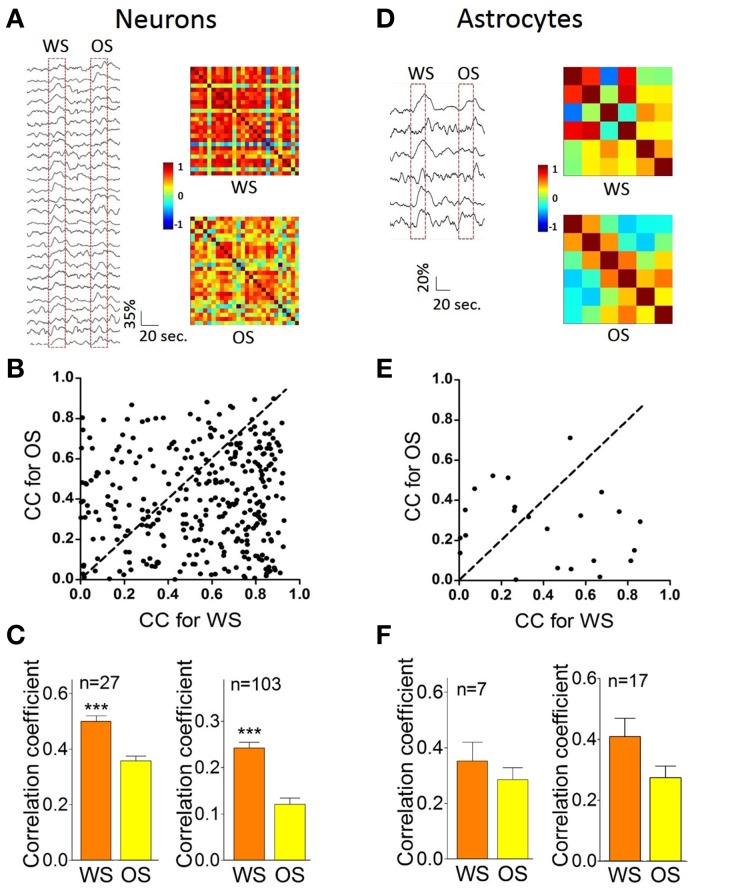
The individual CR cells in the barrel cortex recognize odor and whisker input signals by coding their distinct activity patterns. (A–C) Present the data from neuron pairs and (D–F) show the data from astrocyte-pairs. (A) Shows temporal patterns from CR neurons in response to WS (right-top panel) and OS (right-bottom one) from an experiment, in which the responses of 27 neurons to WS and OS (red dash-line boxes) are presented in left panel. Calibration bars are 35% changes and 20 s. Each pixel in matrices denotes the peak value of correlation coefficient for a pair of cells. Dark-red pixels show the best cross-correlation (synchrony), or vice versa. (B) Illustrates correlation coefficients (CC) for OS vs. CC for WS in this example. A dash-line in 45° denotes equal values in CC for OS vs. CC for WS. The different activity synchronies are seen among most neuron pairs in response to WS and OS. (C) Shows statistical comparisons in CC peak values for the neurons in response to WS and OS from this experiment (left panel; p < 0.001, n = 27; paired t-test), and those for the neurons in response to WS and OS from five experiments (right; p < 0.001, n = 103; paired t-test). (D) Shows temporal patterns from CR astrocytes in response to WS (right-top panel) and OS (right-bottom) from an experiment, in which the responses of the astrocytes to WS and OS are showed in left panel. Calibration bars are 20% changes and 20 s. (E) Shows CC for OS vs. CC for WS in this example. Dash-line in 45° indicates equal values in CC for OS vs. CC for WS, indicating the different activity synchrony among most astrocyte pairs in response to WS and OS. (F) Illustrates statistical comparisons in CC peak values for the astrocytes in response to WS and OS from this experiment (left panel; p = 0.35, n = 7; paired t-test), and those for the astrocytes in response to WS and OS from five experiments (right; p = 0.1, n = 17; paired t-test). ***p < 0.001.